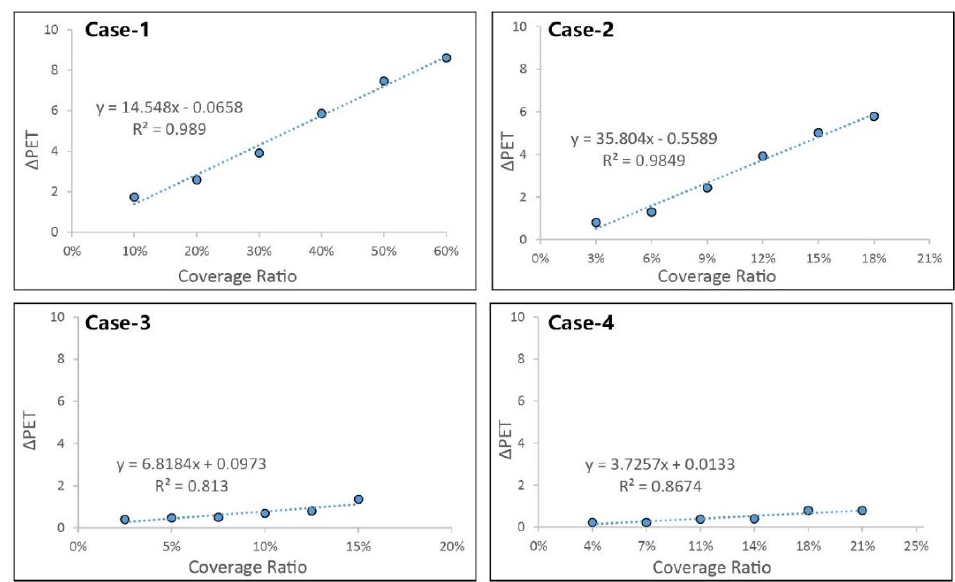
Figure 18. Correlation between thermal comfort and coverage ratio of di ff erent parameter in canyon space at 3:00 pm.